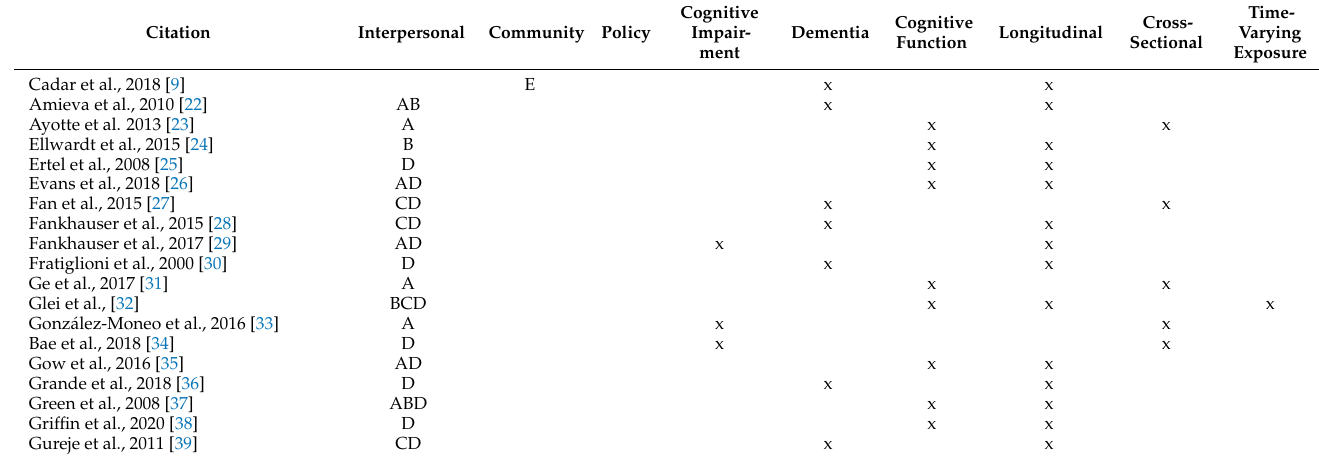
Table 3. Social environment level, cognitive aging and dementia outcome and study design for included individual studies.